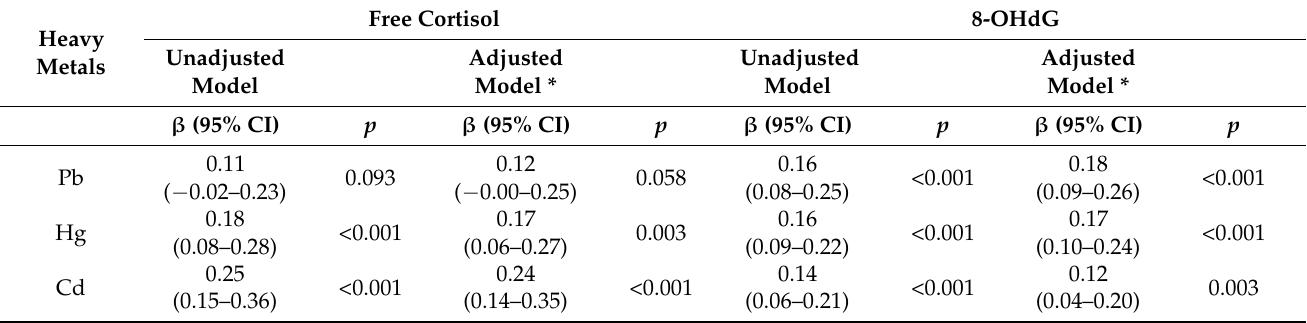
Table 2. Association between heavy metals and biomarkers in maternal urine samples (n = 182).